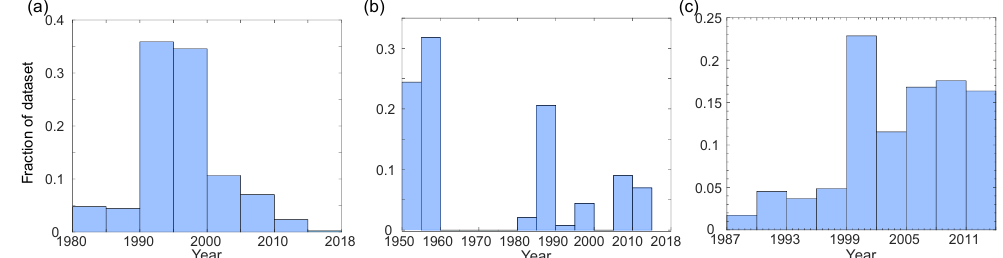
Figure 3. Histograms showing the date taken and associated fraction of the density dataset for (a) Antarctica, (b) Greenland excluding Summit Station, and (c) Summit Station. Please note the different timescales on the x